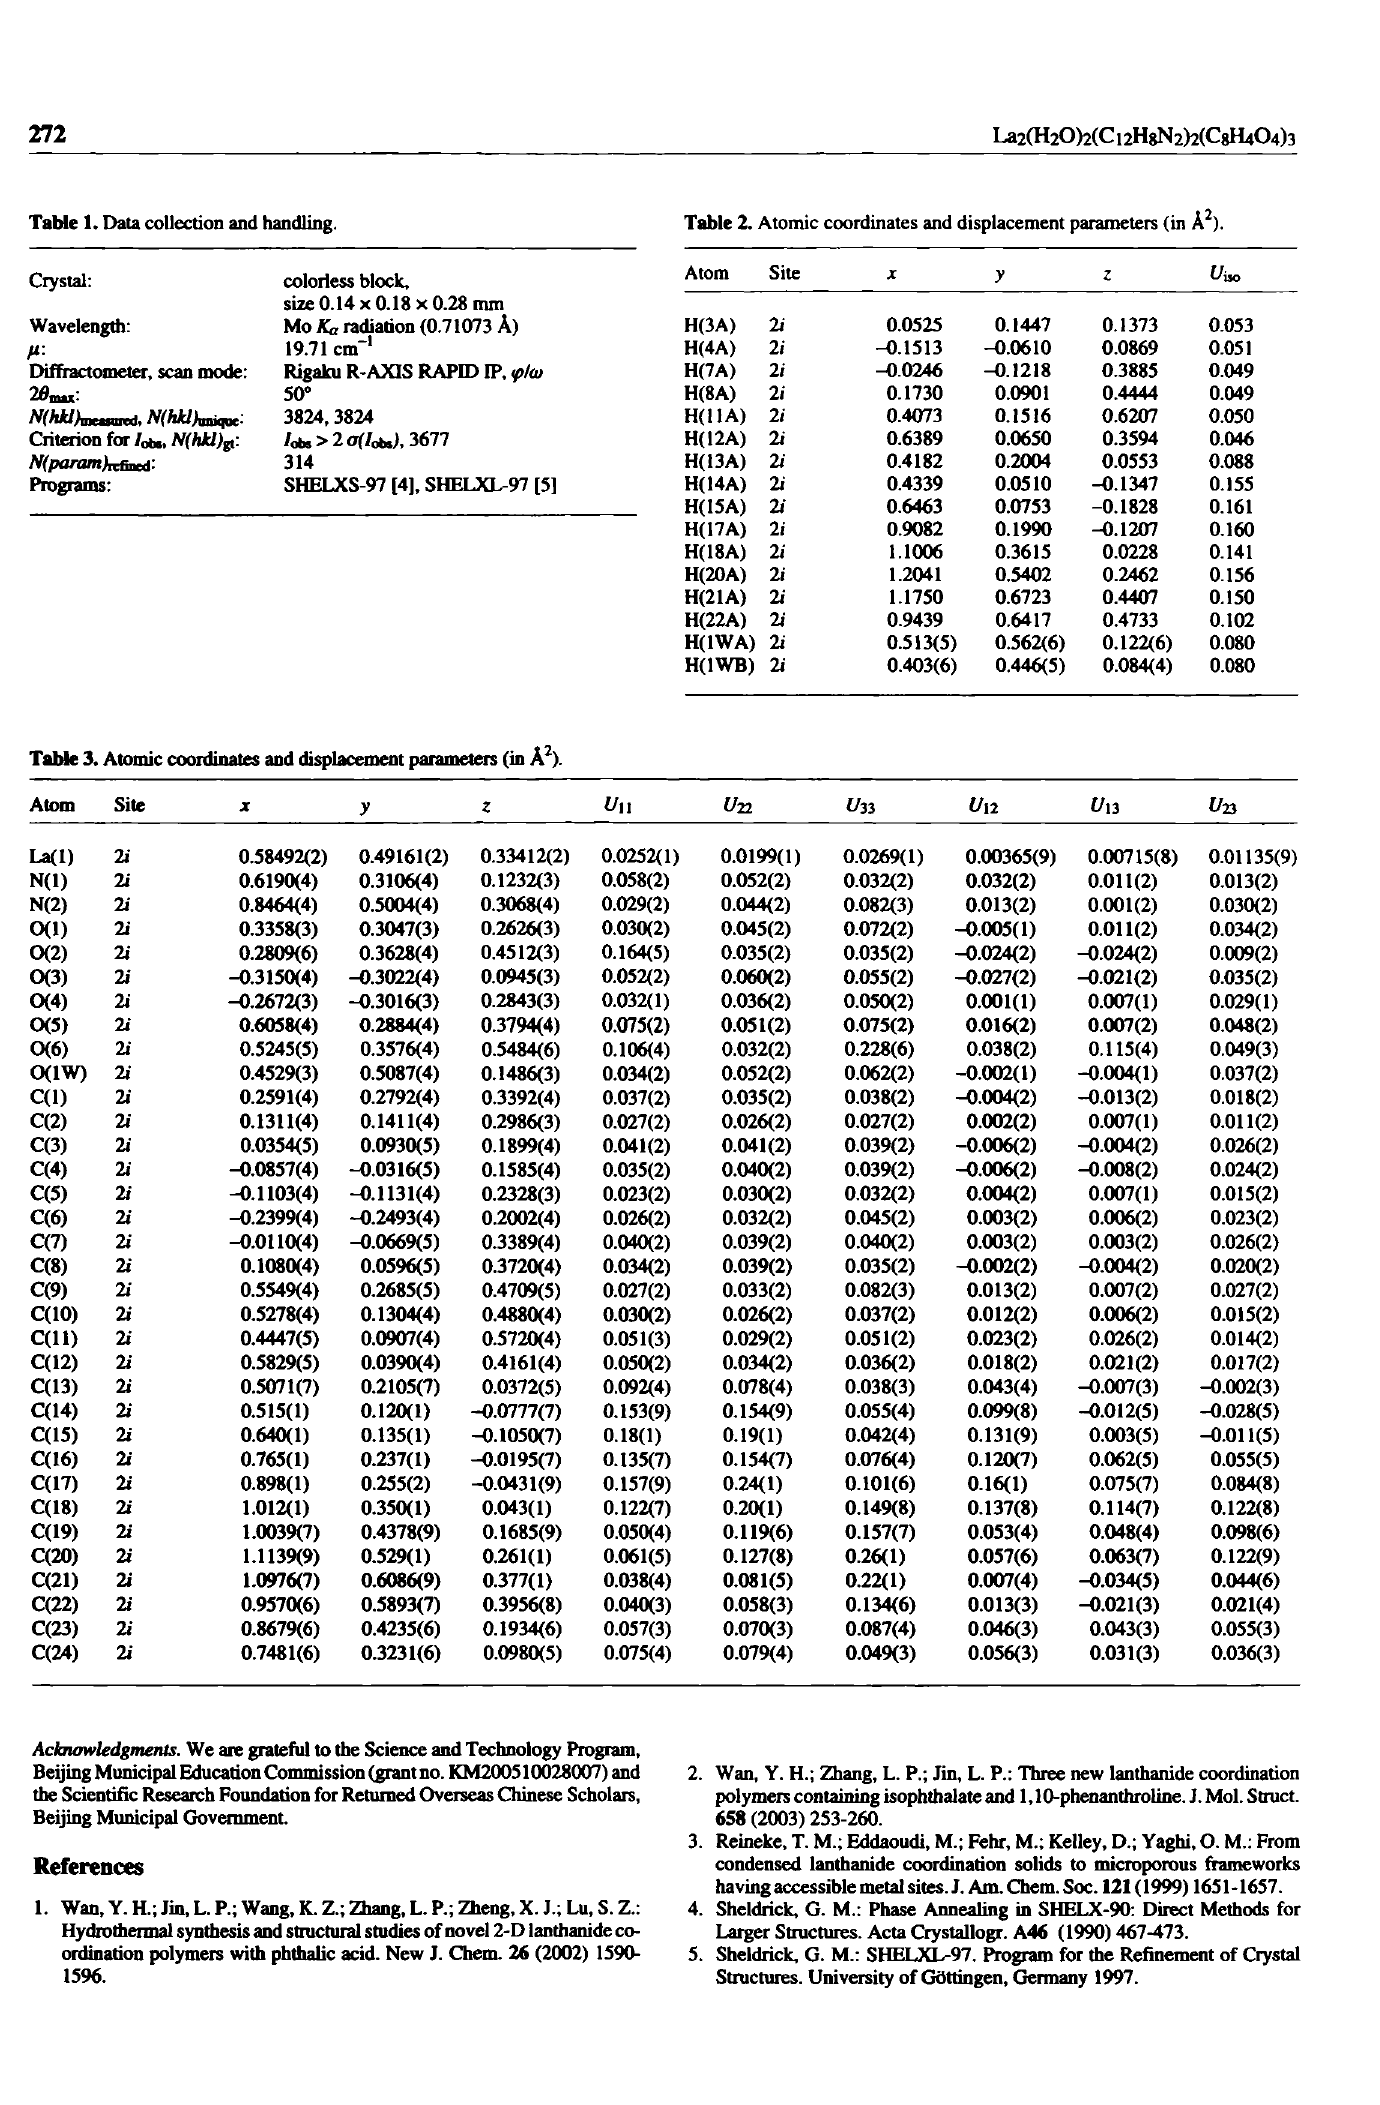
Table 3. Atomic coordinates and displacement parameters (in A 2